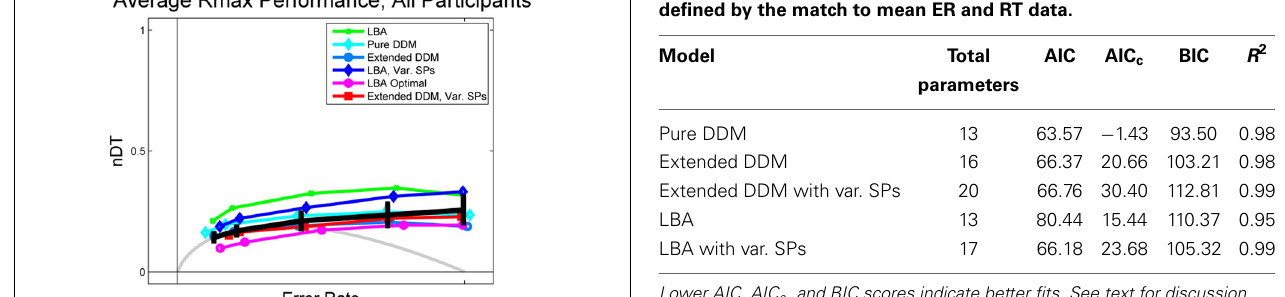
FIGURE 4 | Data and fits to Rmax behavior averaged over all participants, with comparison to OPCs for pure DDM (gray) and LBA (purple open circles). Data is shown in black, with error bars being the mean of standard errors for each participant within the given ER bin. LBA fits (green dots and dark blue diamonds) overestimate mean normalized DTs, but the OPC for the LBA underestimates them.